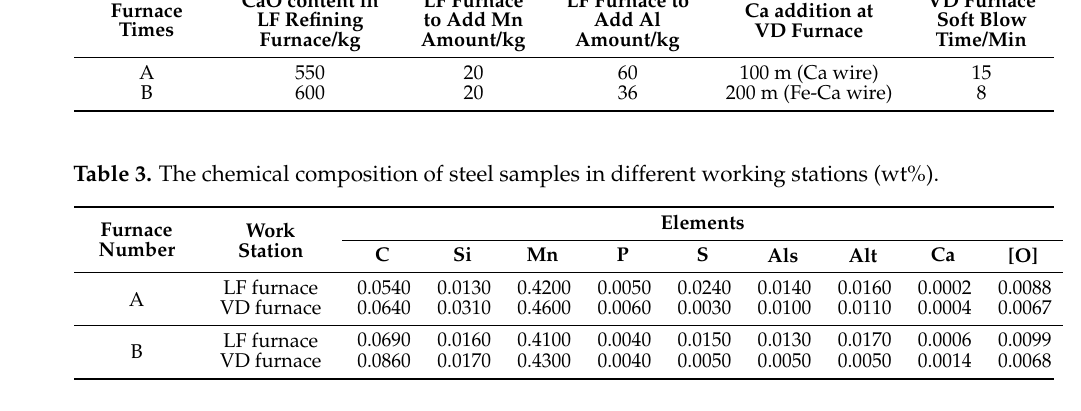
Table 3. The chemical composition of steel samples in different working stations (wt%).